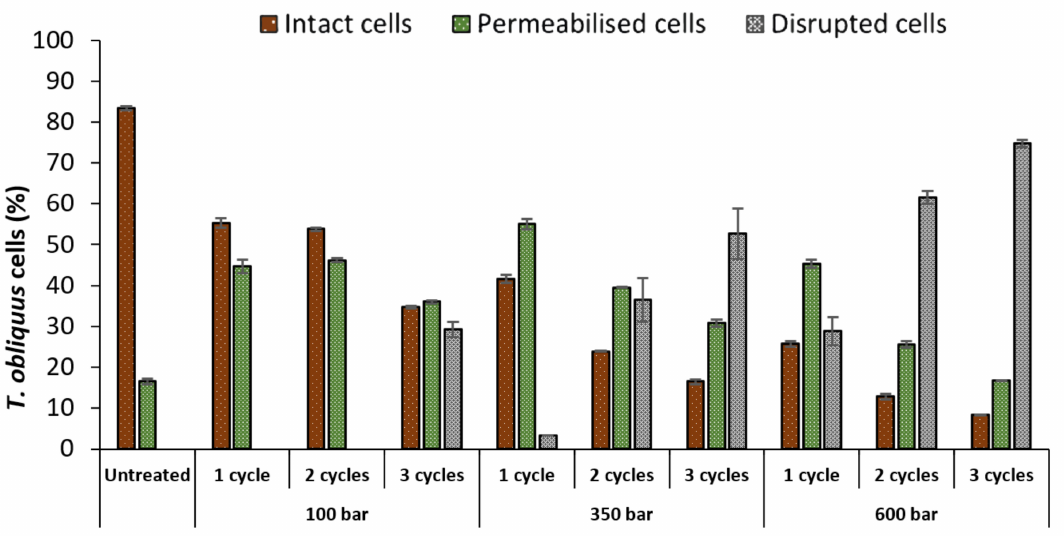
Figure 2. Percentages of intact, permeabilised and disrupted Tetradesmus obliquus cells after high- pressure homogenization at different pressure or cycles, determined by flow cytometry. Data are shown as mean ± standard deviation ( n =